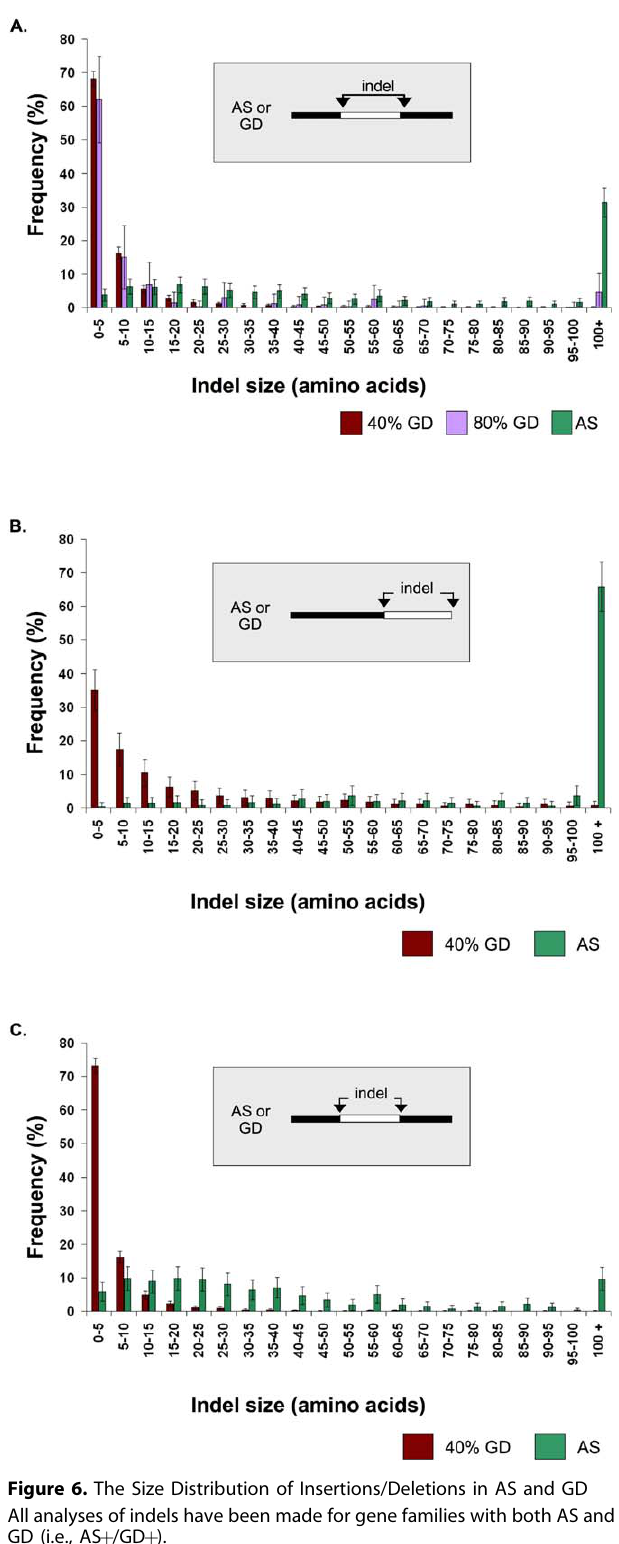
Figure 7. The Overlap between AS and GD Insertions/Deletions The overlap between AS and GD indels is very small. For the frequency distribution of the overlap between AS and GD indels, AS indels were taken as reference. GD data at 80% seq.id. are shown in light violet, while GD data at 40% seq.id. are shown in dark and light blue for both all indels and only short indels ( (cid:5) 30aa), respectively. Given the small overlap, AS and GD indels are likely to affect different locations in protein structure.